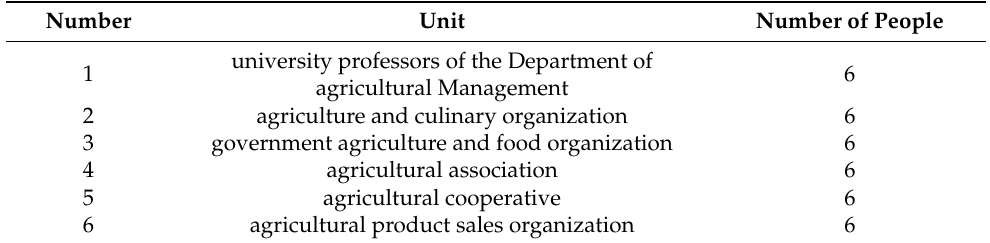
Table 1. Fuzzy Delphi technique general information of experts in various fields.